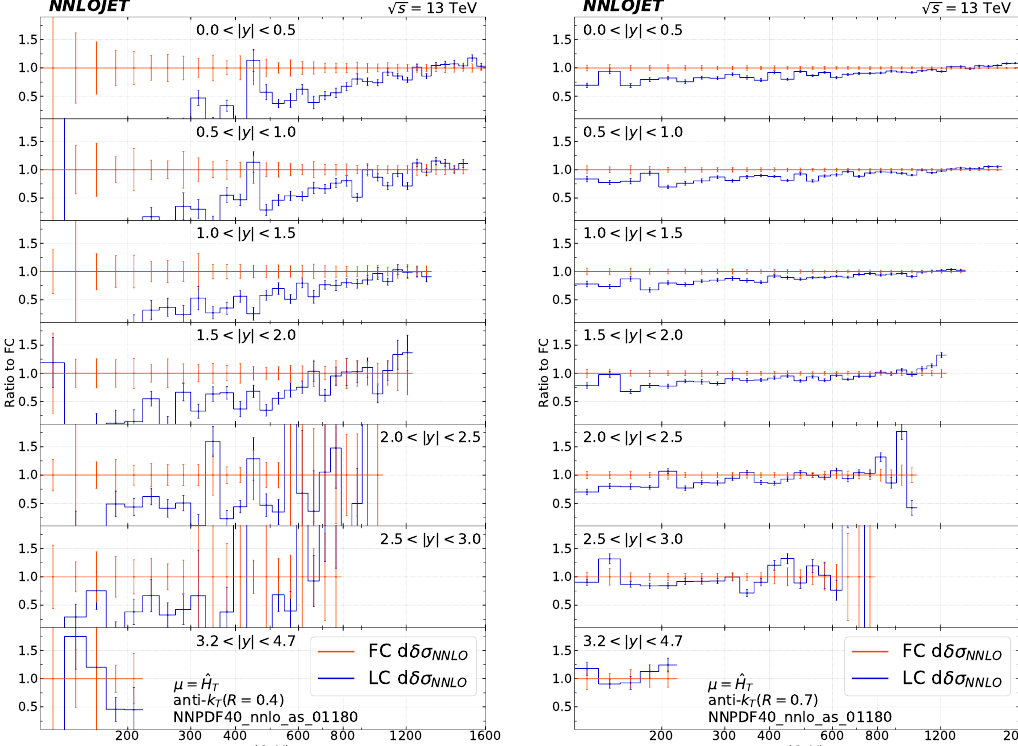
Figure 7 . NNLO coefficient d δσ NNLO at LC (blue) and FC (red) predictions of the R = 0 . 4 (left) and R = 0 . 7 (right) single jet inclusive cross section as function of p T for all the considered rapidity slices, normalized to the FC prediction. Ratios are evaluated at the central scale and error bars represent numerical integration errors